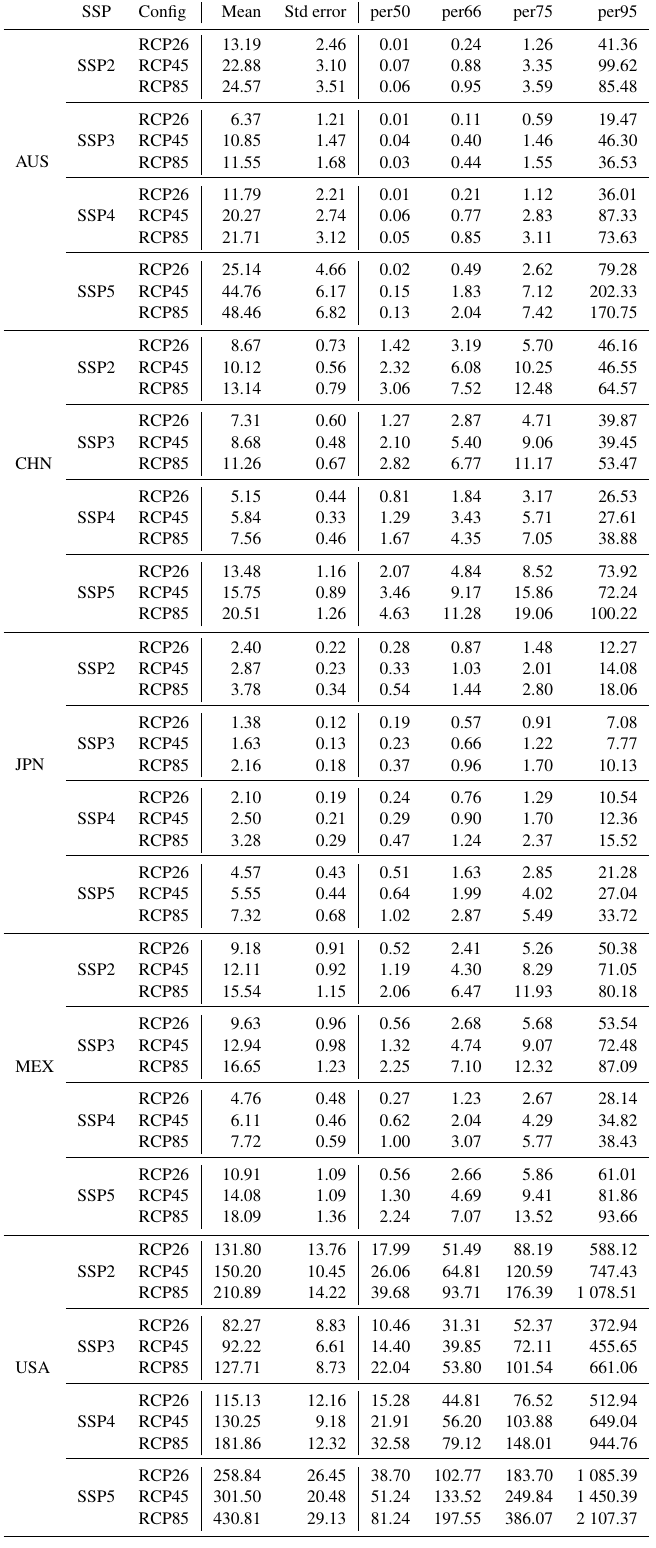
Table A6. Examples of countries’ damage statistics in USD billion ( α 1 = 1, α 2 =